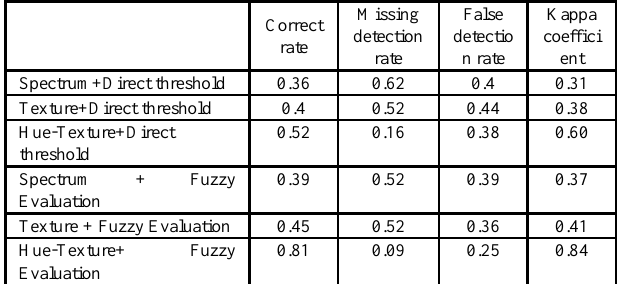
Table 1. Accuracy Comparison of Different Detection Methods